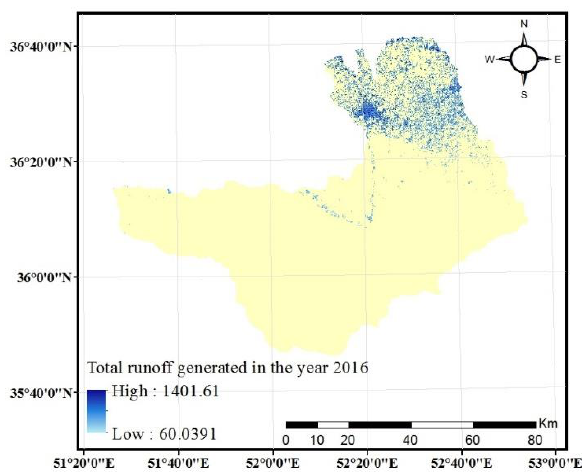
Figure 8. The total runoff generated during the year 2016 in the Babol catchment.